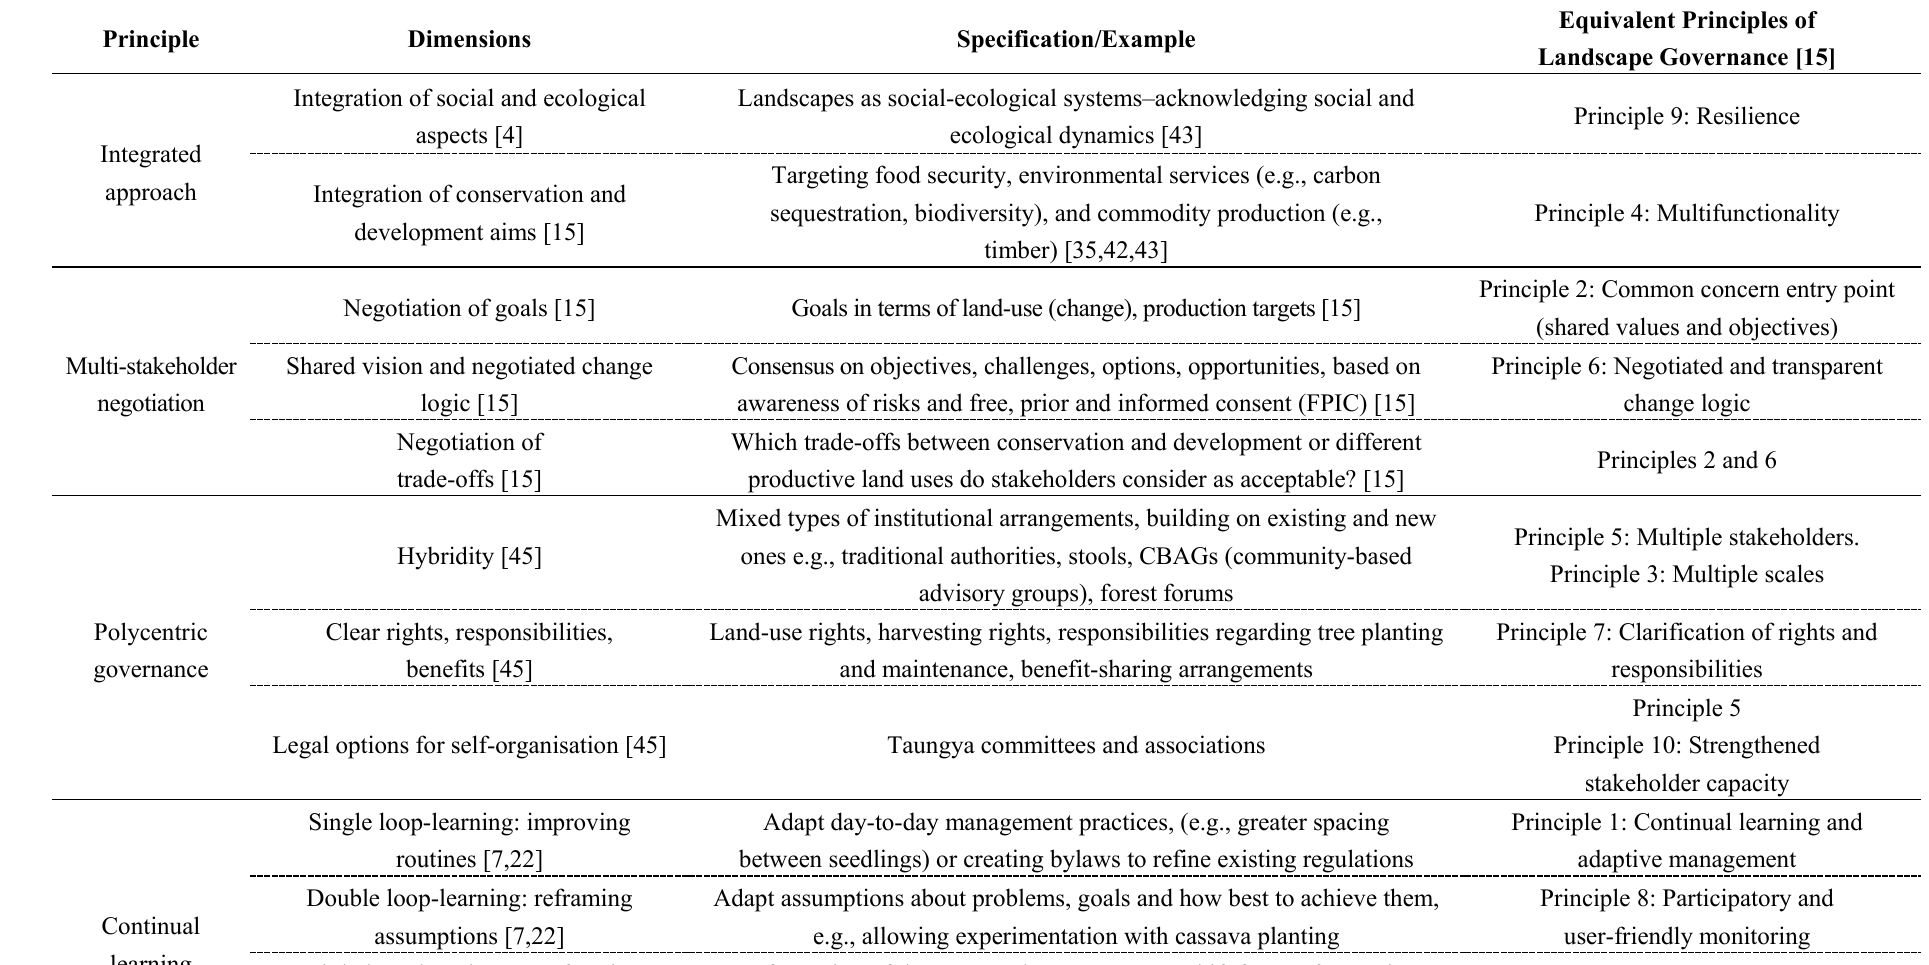
Table 2. Principles for adaptive landscape